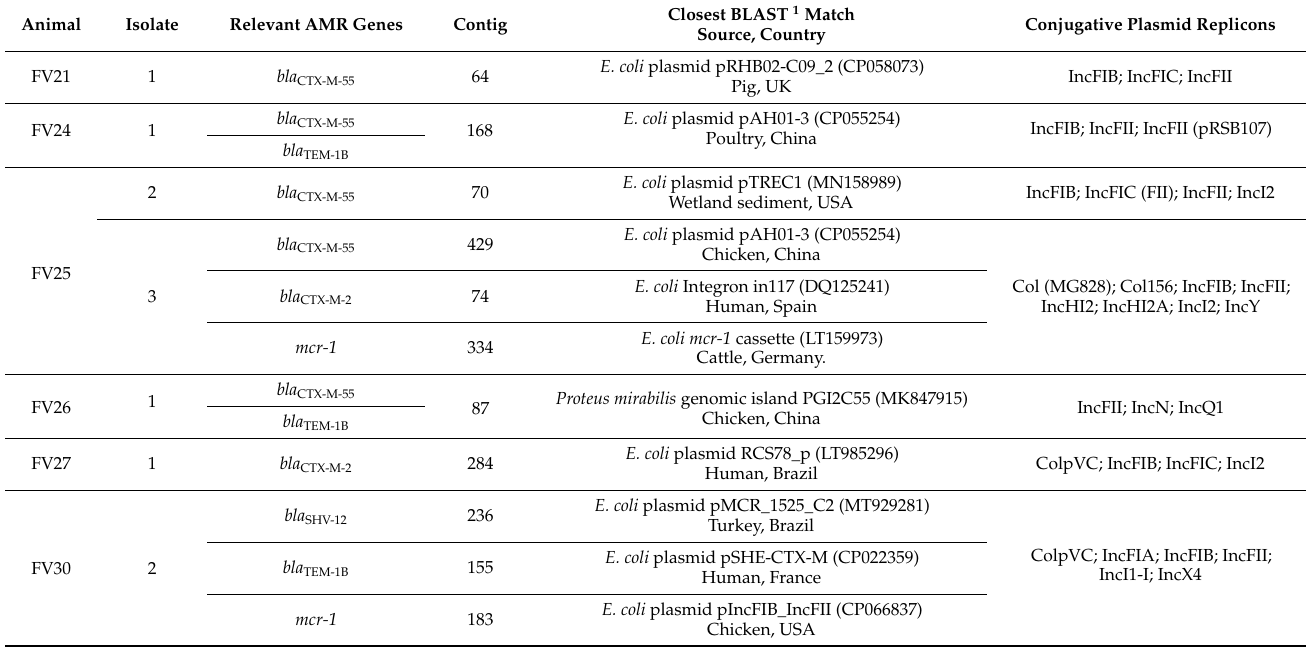
Table 4. Detection of the conjugative plasmid replicons and similarity analyses of the critical im- portant AMR genes detected in seven ESBL-positive Escherichia coli isolates from six dogs fed raw meat-based diets in Brazil.